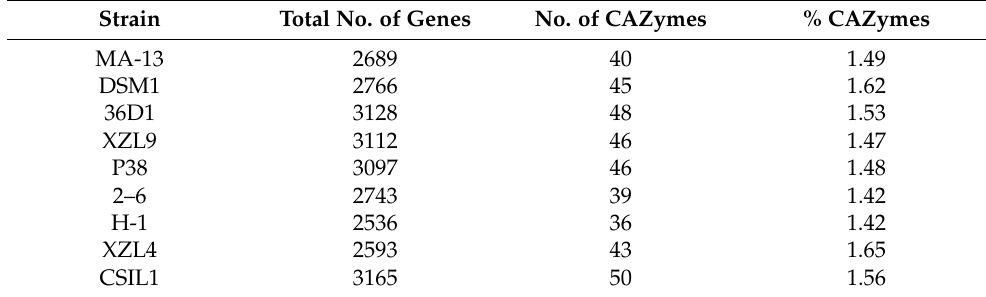
Table 2. CAZymes distribution in the genomes of W. coagulans strains. The total number of genes (for each genome) is based on the data obtained by NCBI and the number of CAZymes has been derived from Search with dbCAN2 HMMs of CAZy families.